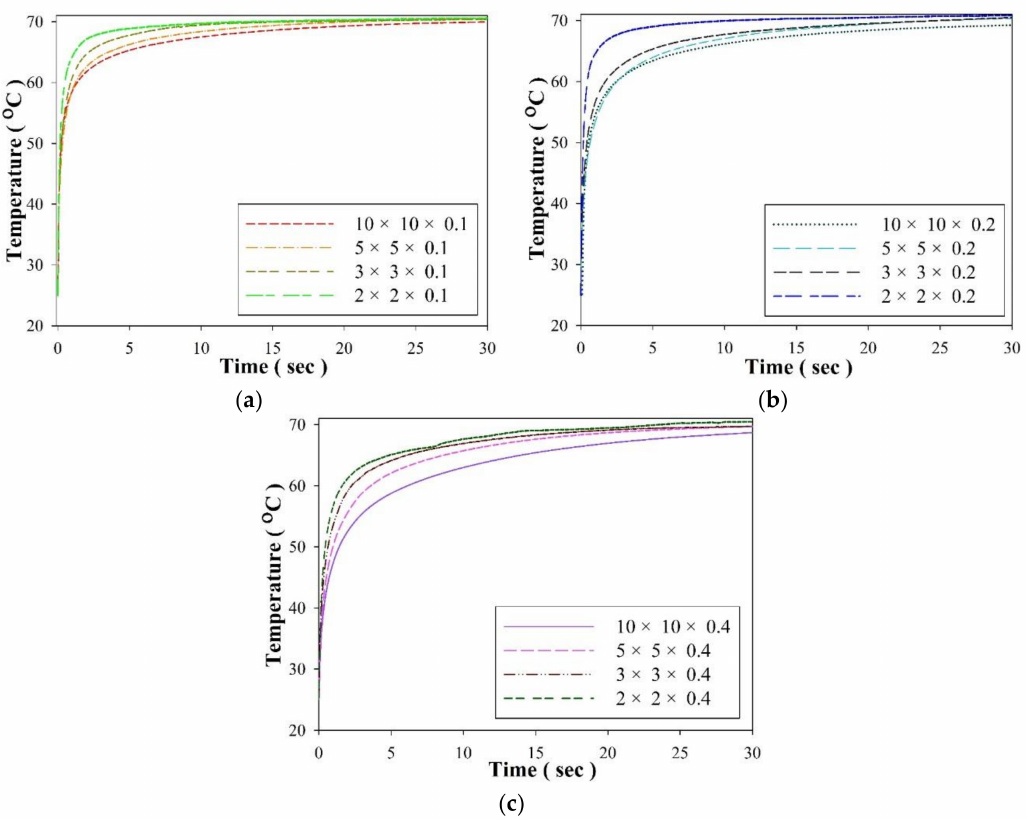
Figure 5. Temperature profiles of the PZT cells with various geometries and thicknesses of: ( a ) 0.1 mm, ( b ) 0.2 mm and ( c ) 0.4 mm in the thermal bath experiment.